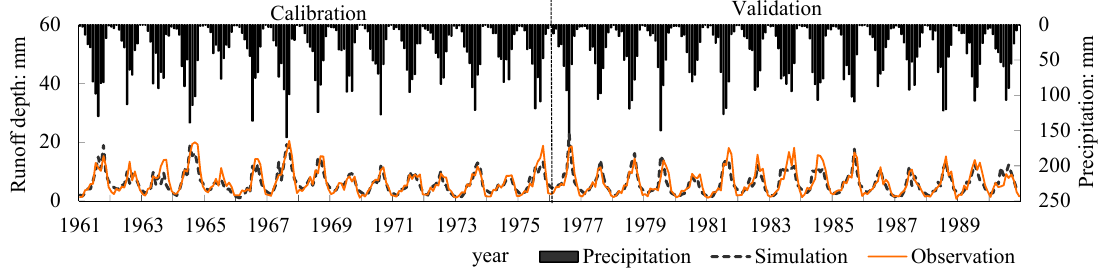
Figure 2. Monthly precipitation and observed/simulated runoff through the Huayuankou hydrological station on the Yellow River (1961–1990).